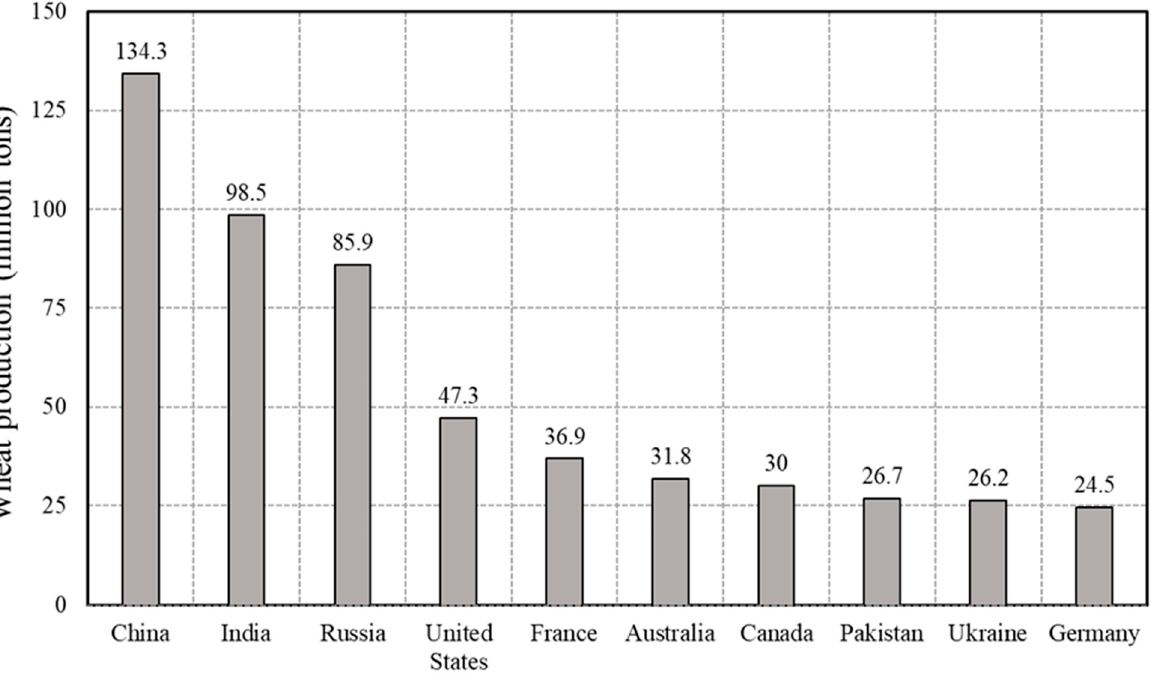
Figure 1. Total wheat production in the top ten countries in 2021. (Data source: FAOSTAT.)